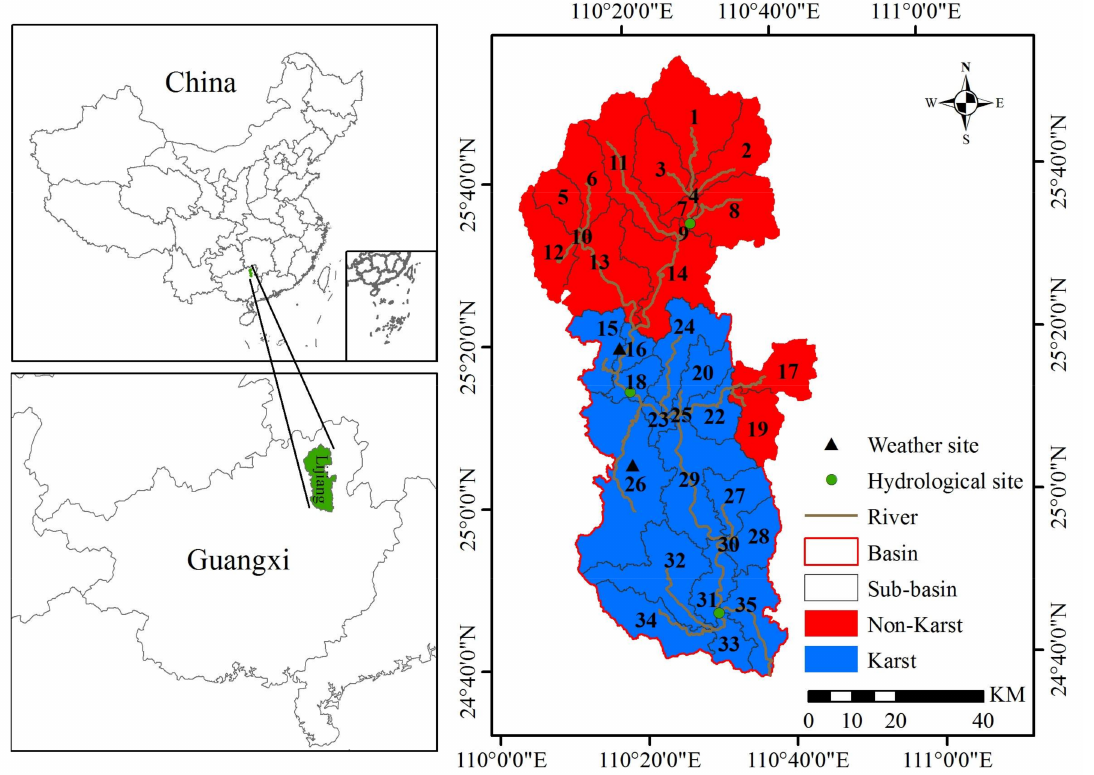
Figure 1. Location of the study area and distribution of sub-basins, karst and non-karst areas. The Lijiang River is a rain-sourced river. The precipitation in the basin is affected by monsoon activity, and the spatial and temporal distribution of precipitation is